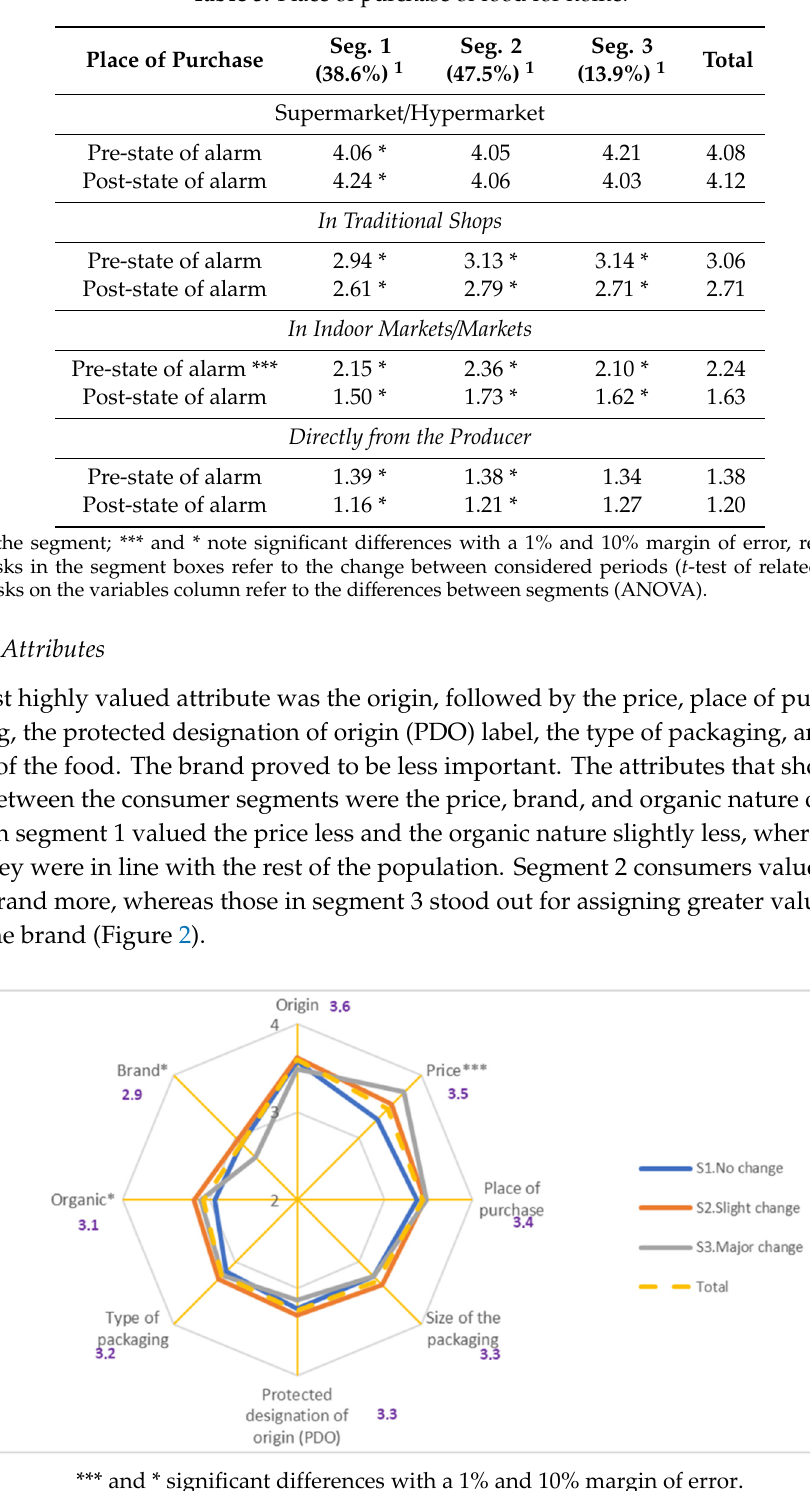
Figure 2. Attribute value by consumer segments.